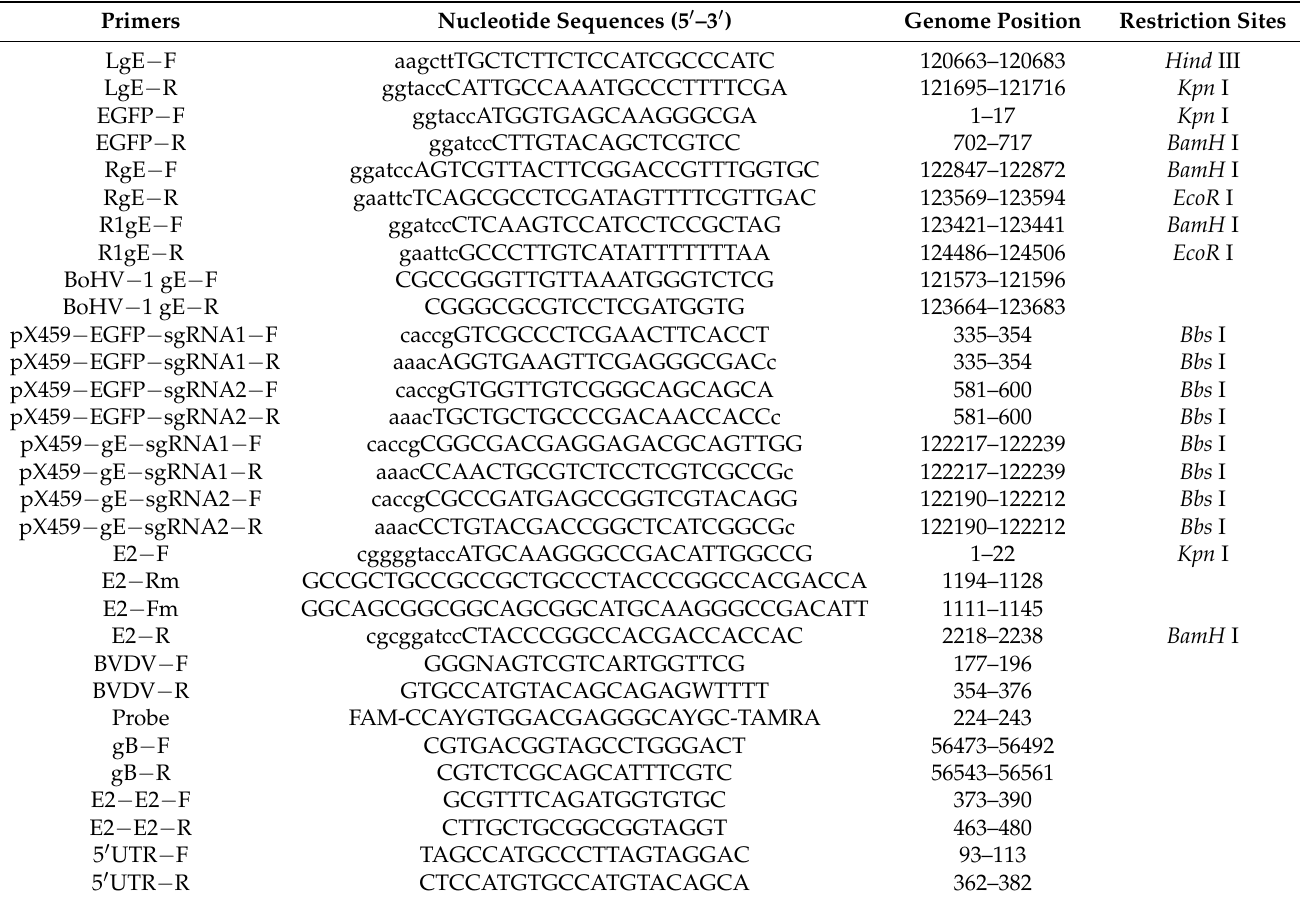
Table 1. Primers, sgRNAs and restriction sites were used in this